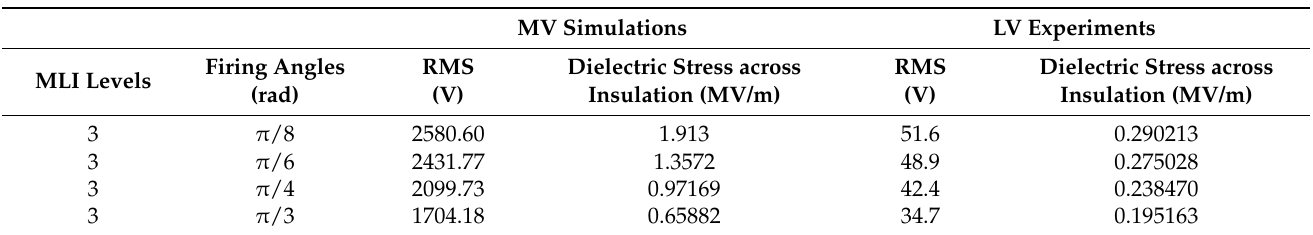
Table 8. Comparison of simulation and hardware results to check the effect of the increase in firing angles for a 3-level inverter output.